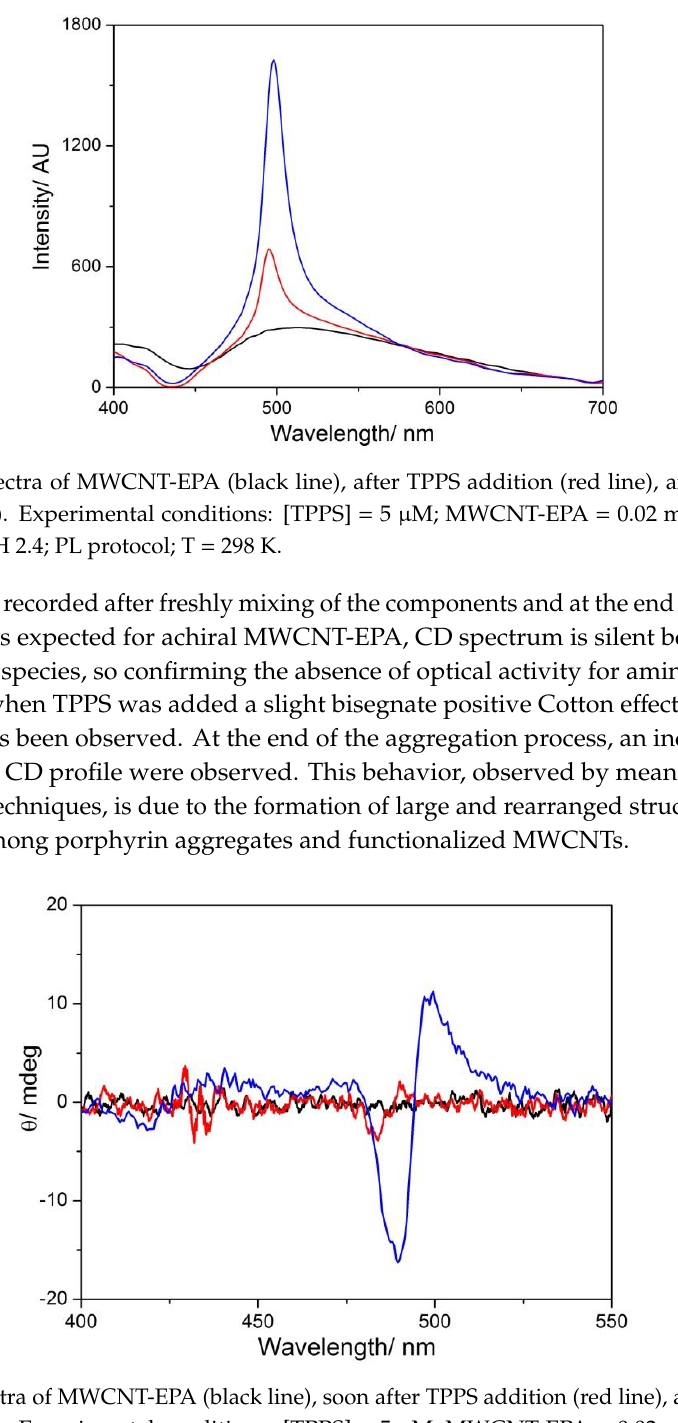
Figure 6. RLS spectra of MWCNT-EPA (black line), after TPPS addition (red line), and 1 day after mixing (blue line). Experimental conditions: [TPPS] = 5 µM; MWCNT-EPA = 0.02 mg/mL; 10 mM citrate buffer at pH 2.4; PL protocol; T = 298 K.